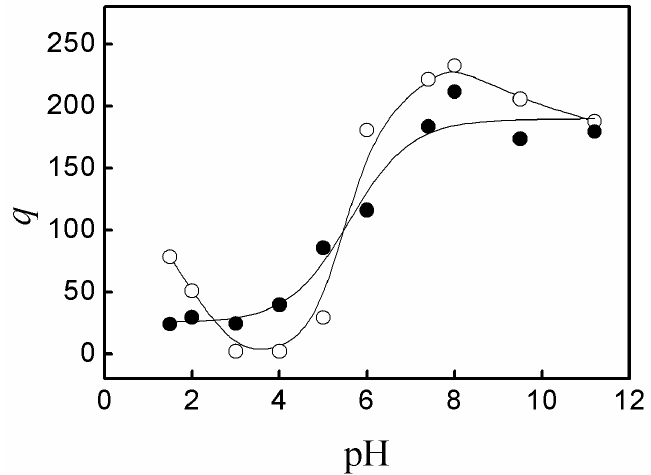
Figure 5. Variation of the swelling ratio ( q ) of P(AA- co -NVF) (solid) and P(AA- co -VAm) (hollow) microgel as a function of pH.